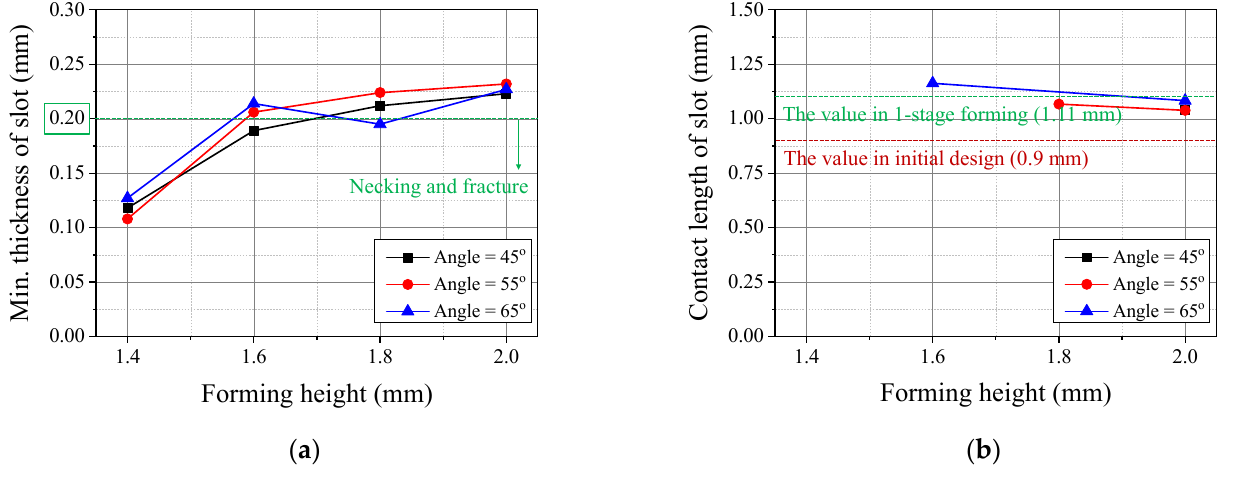
Figure 13. Changes in ( a ) minimum thickness and ( b ) contact length of the slot in the slitting-preforming process according to slope angle and forming height.